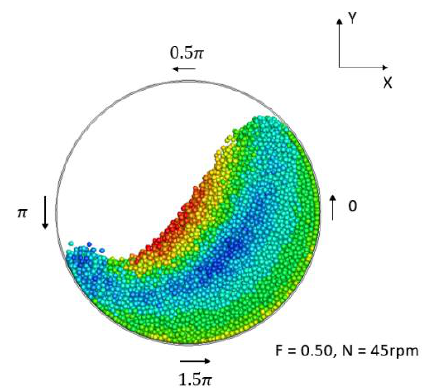
Fig. 2 Particle flow in the rotating drum (particle color represents the magnitude of velocity).